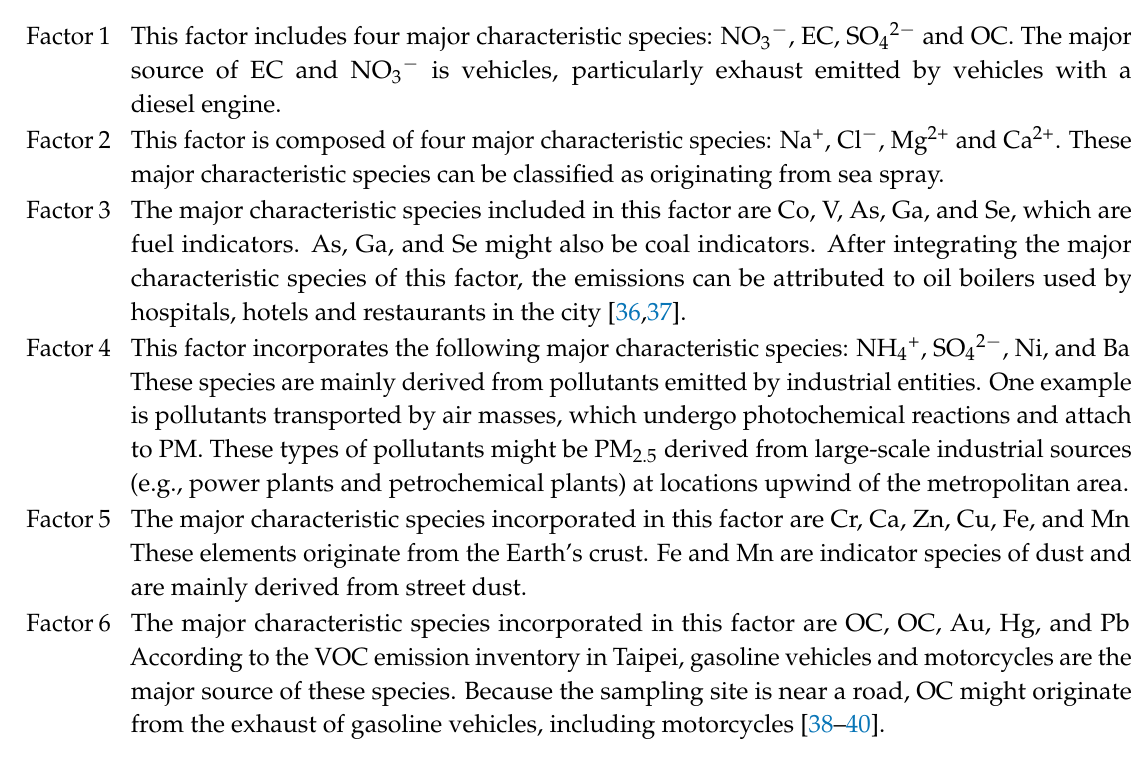
Table 2. PMF analysis of major characteristic